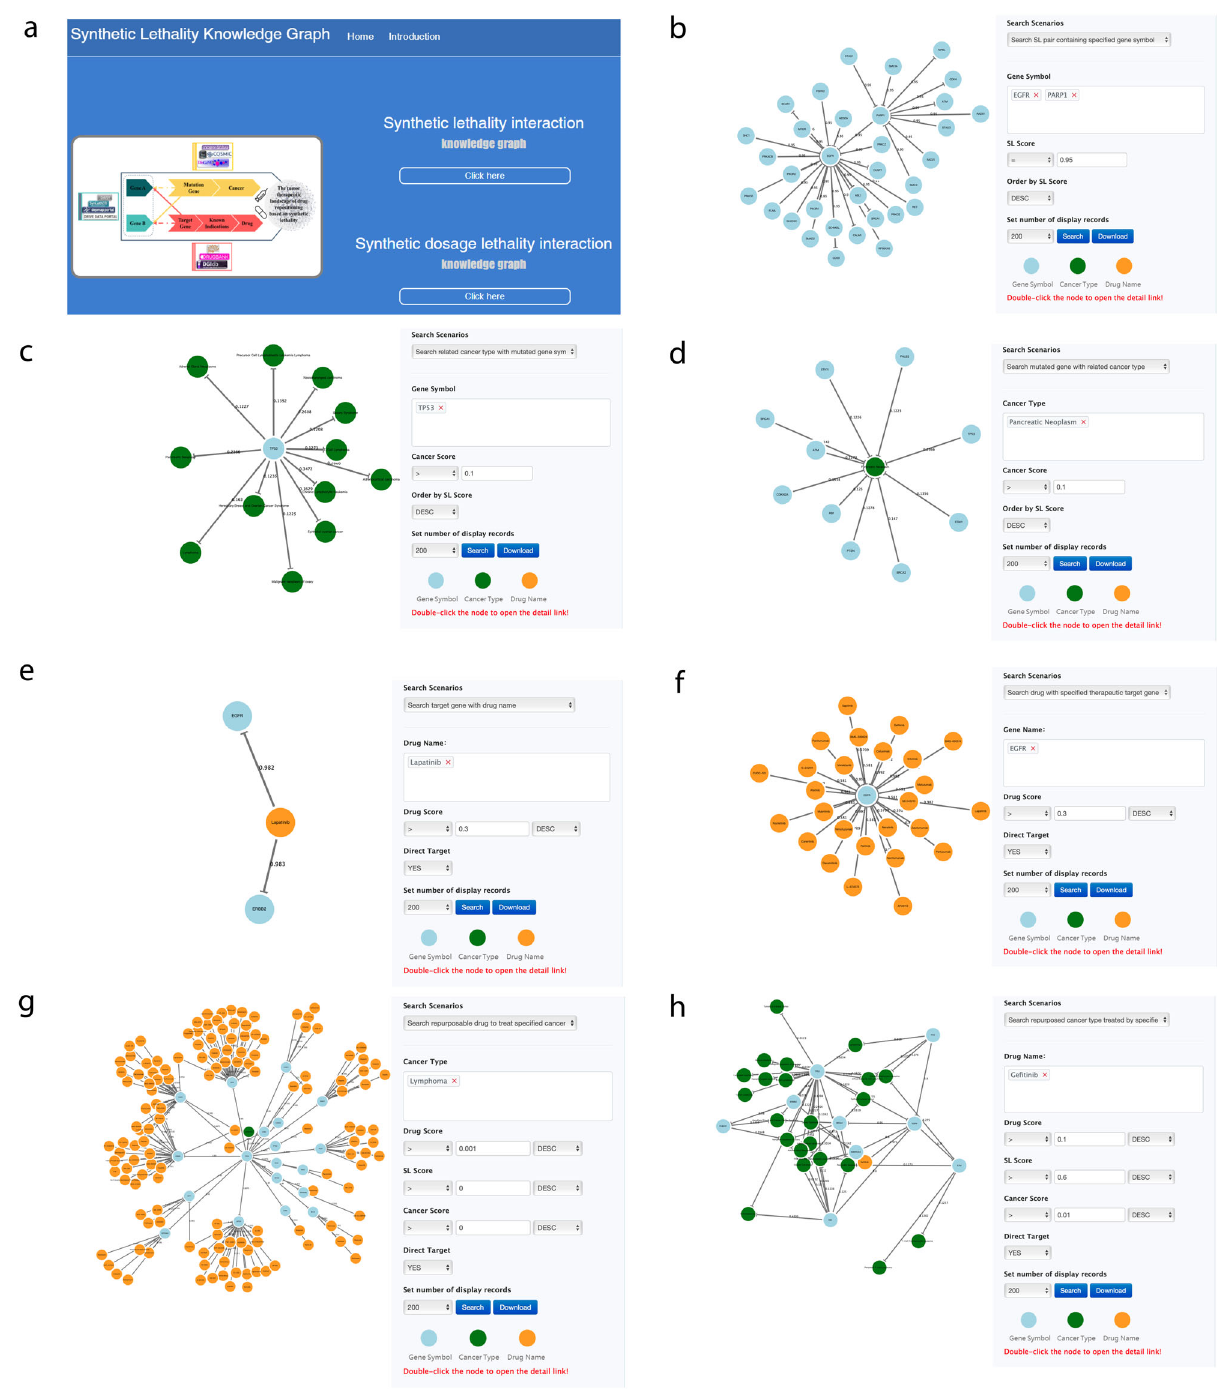
Fig. 7 The query modes of SLKG webserver. a Homepage of SLKG. b – h 7 query modules to explore the tumor therapy landscape based on the principle of “ synthetic lethality ”